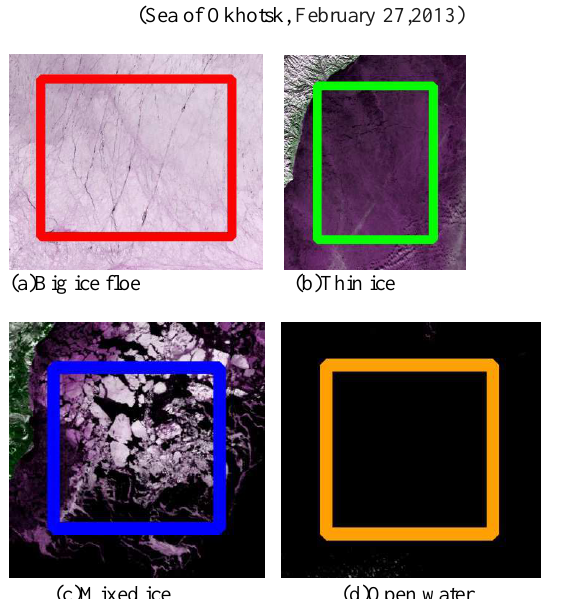
Figure 4. Comparison of AMSR2 and MODIS images.